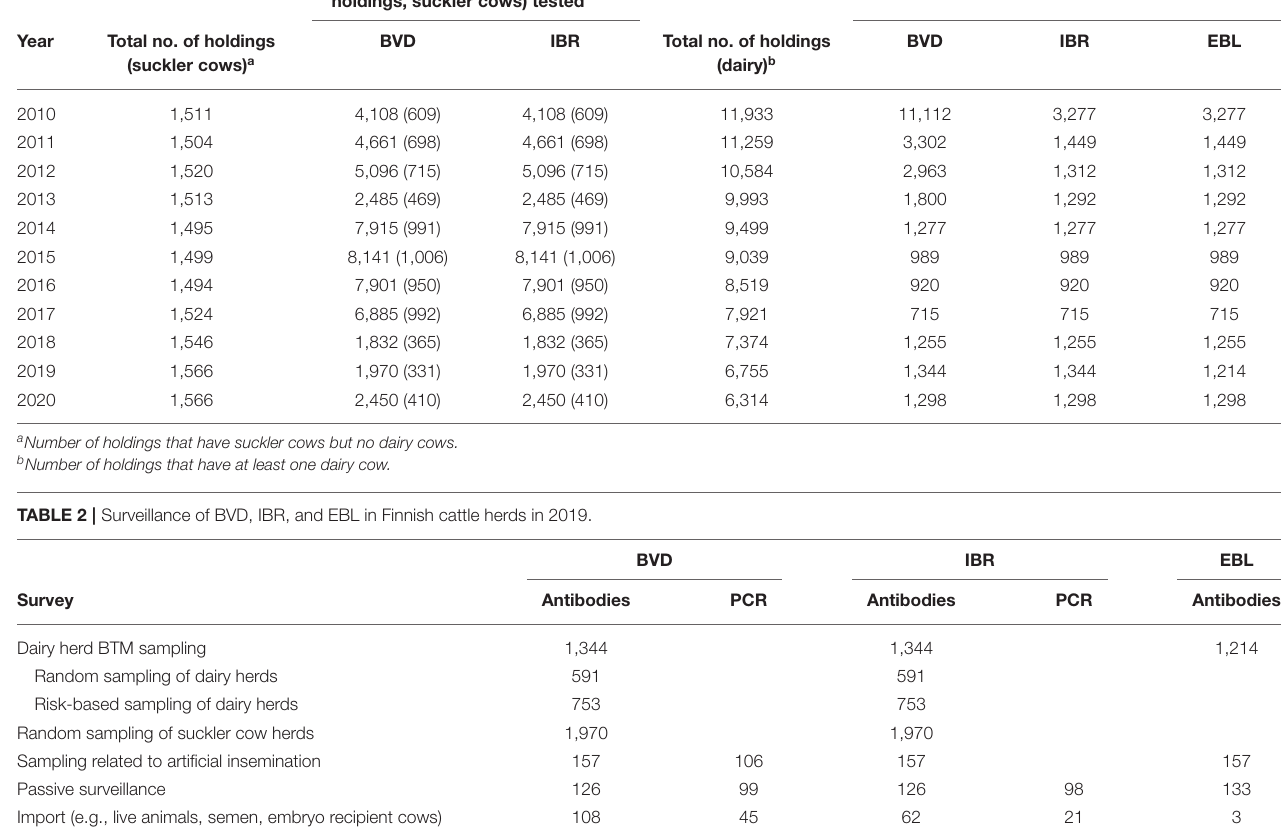
TABLE 1 | BTM and serum sampling for surveillance of BVD, IBR, and EBL in Finnish cattle herds. No. of serum samples (no. of holdings, suckler cows) tested